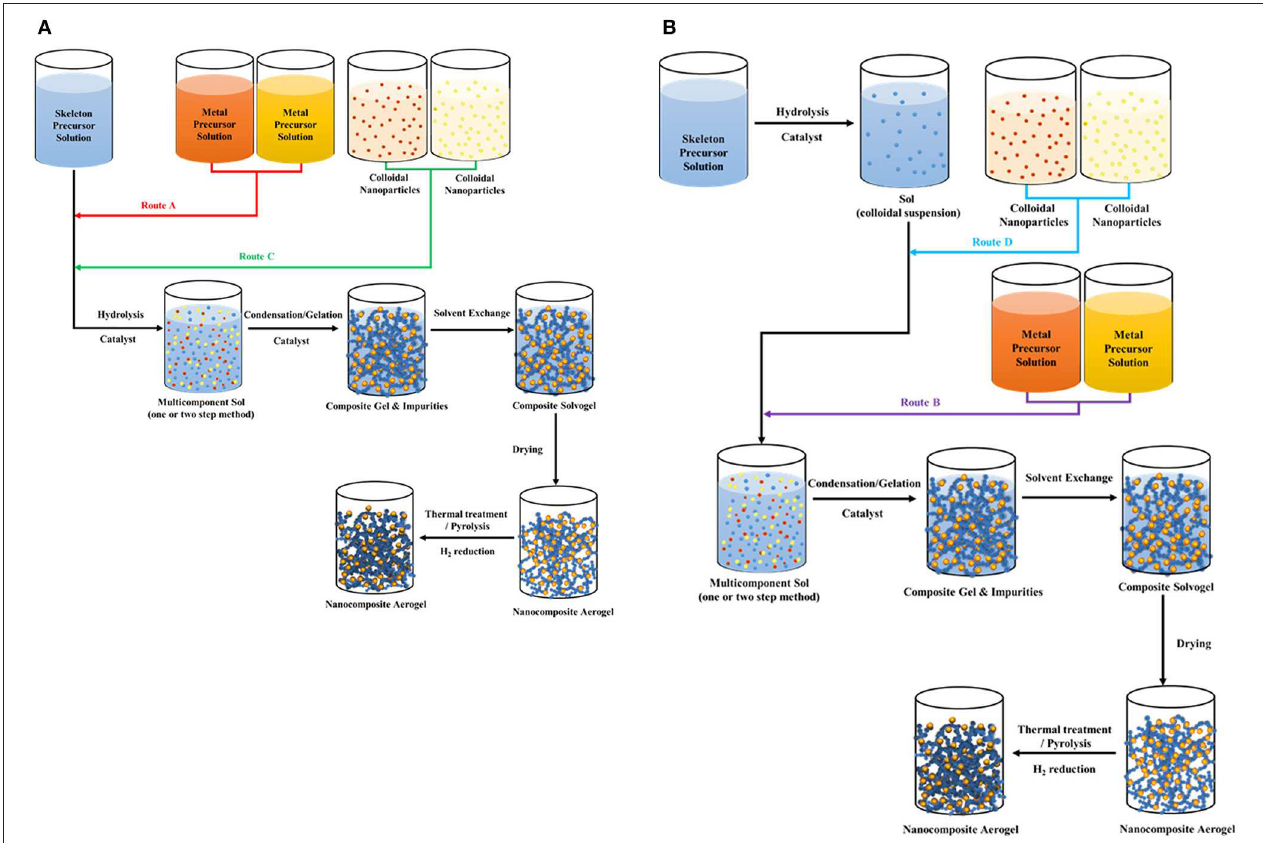
FIGURE 2 | Schematic of preparation of aerogel supported bimetallic NPs via sol-gel method with the addition of MPs (Route A and B) or metal NPs (Route C and D) (A) before hydrolysis and (B) after